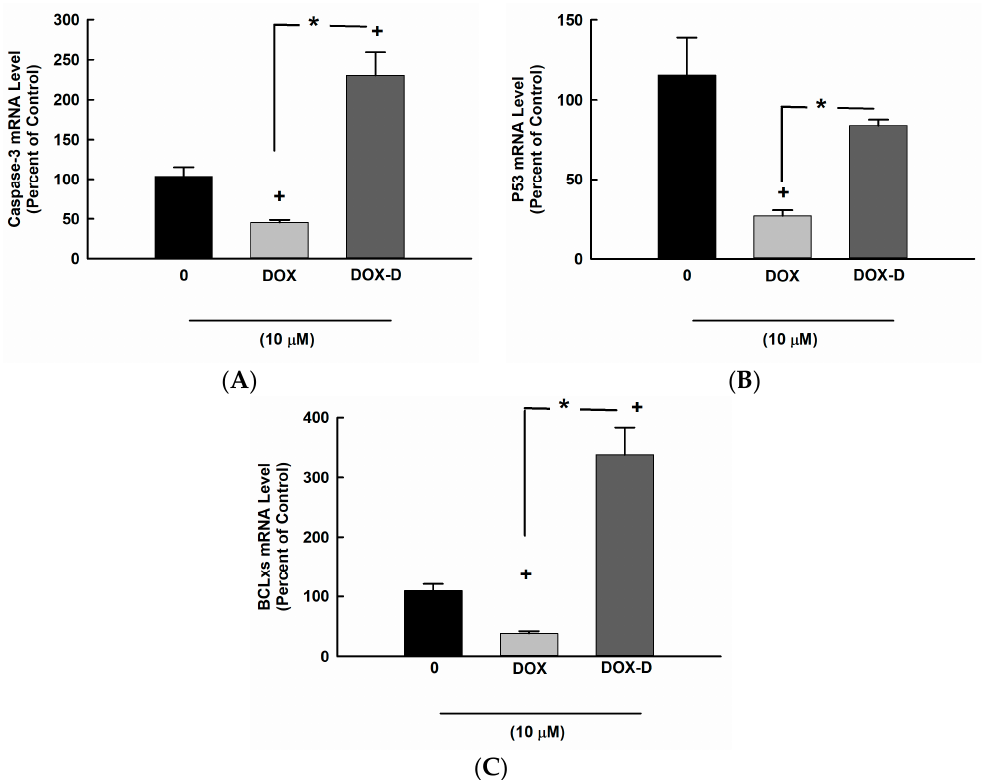
Figure 4. Effect of DOX and DOX-Vit D on proapoptotic genes. MG63 cells were treated for 24 h with 10 µM DOX and DOX-Vit D. Thereafter, total RNA was isolated using TRIzol reagent, and the mRNA levels of ( A ) Caspase-3, ( B ) p53 and ( C ) BCLxs were quantified using real time-PCR and normalized to a β -actin housekeeping gene. The results are presented as the mean ± SEM ( n = 6). + p < 0.05